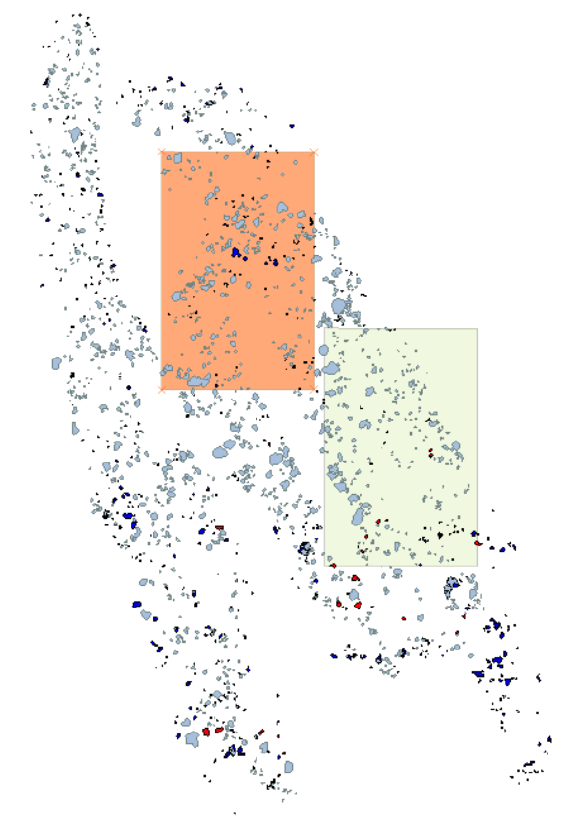
Figure 10. Human annotation errors. After a second annotation session, some of the original labels were found to be false positive (red) or false negative (dark